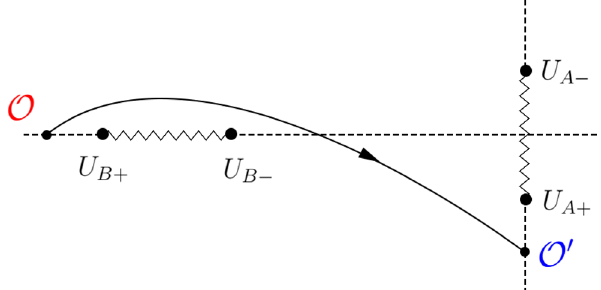
Figure 8 . The path in the U -plane connecting two observers O and O 0 probing the two holonomy saddles for SU(2) theory. π